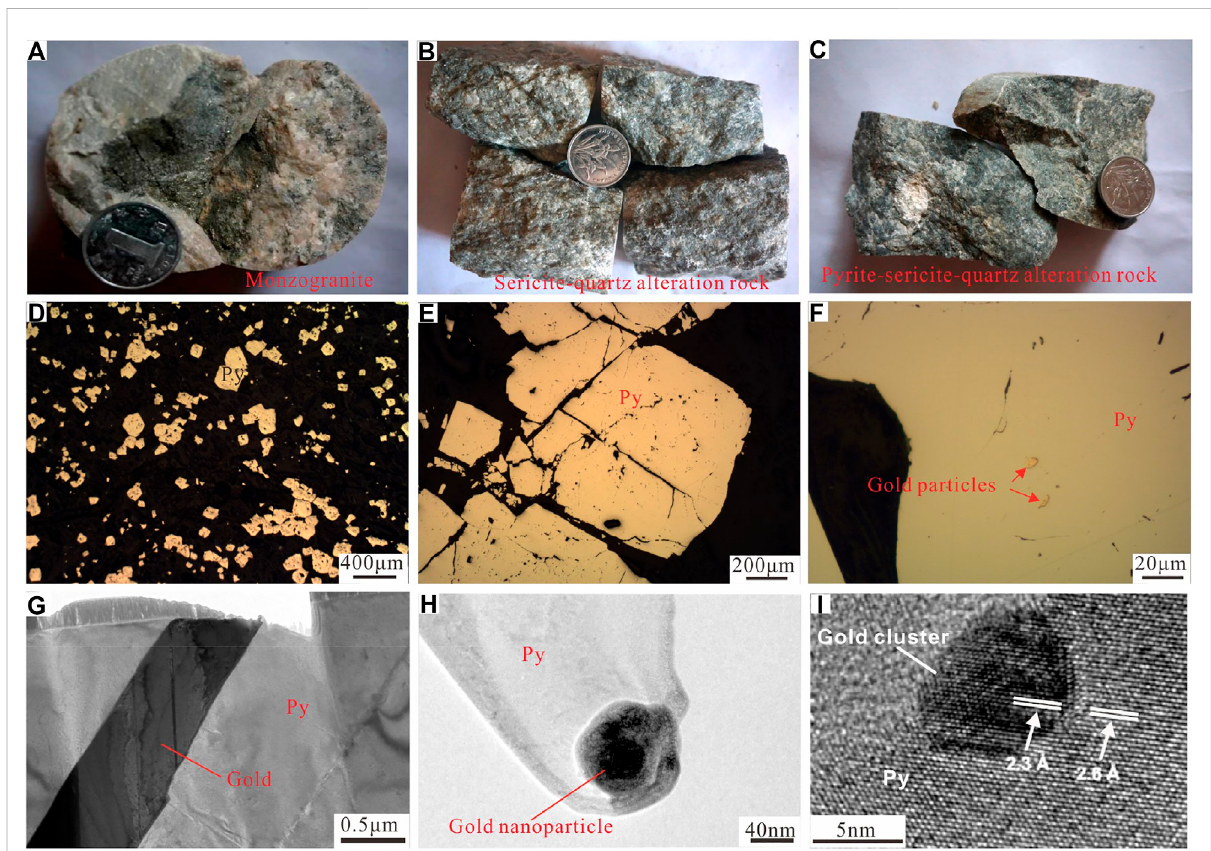
FIGURE 3 The handspecies of typical ore (A – C) ; Gold bearing pyrite (D – G) ; Nanogold particulate (H) (Yang et al., 2016) and gold cluster (I) (Palenik et al.,